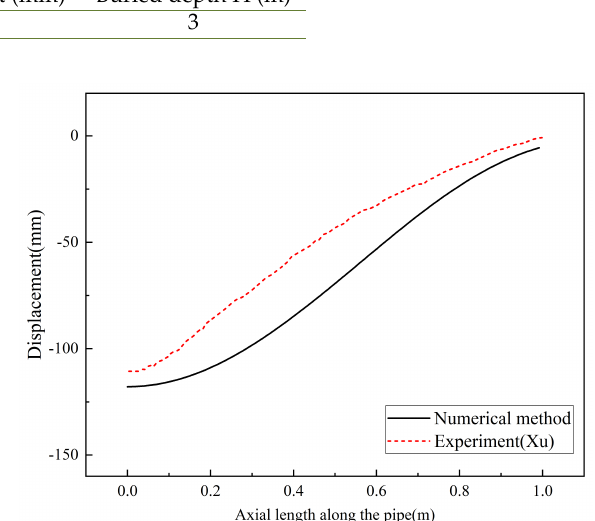
Fig. 2. Comparison between numerical simulation and experimental